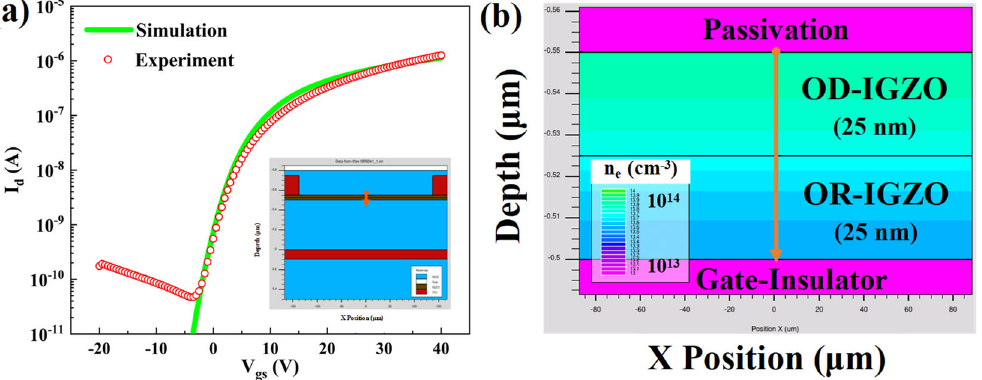
Figure 5. ( a ) The typical transfer curves of the DSCL ‐ TFTs from the simulation results and the ex ‐ perimental data, with the inset being the simulated device structure; ( b ) the simulated electron concentration distribution in the reference device.